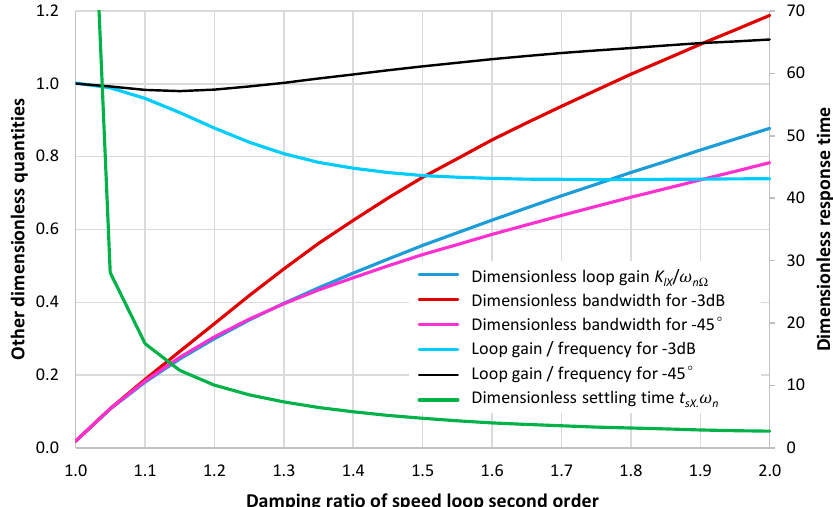
Figure 5. Performance indicators of position control with the P-I implementation of the speed controller giving the fastest response time under a purely real negative closed-loop poles constraint.